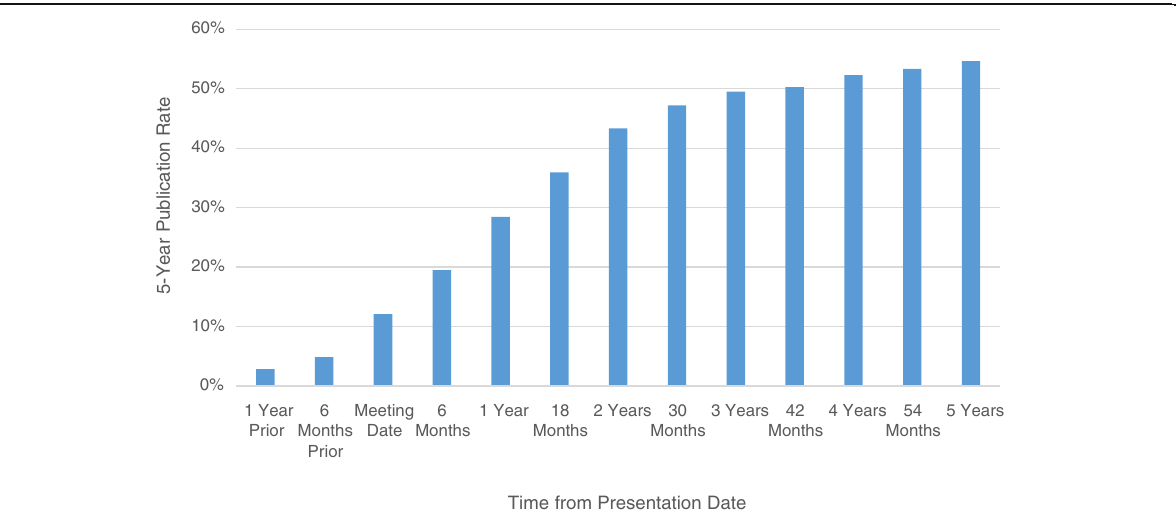
Fig. 1 Cumulative graph demonstrating the frequency with which presentations at the ESSKA congress were ultimately published at various points in time from the meeting